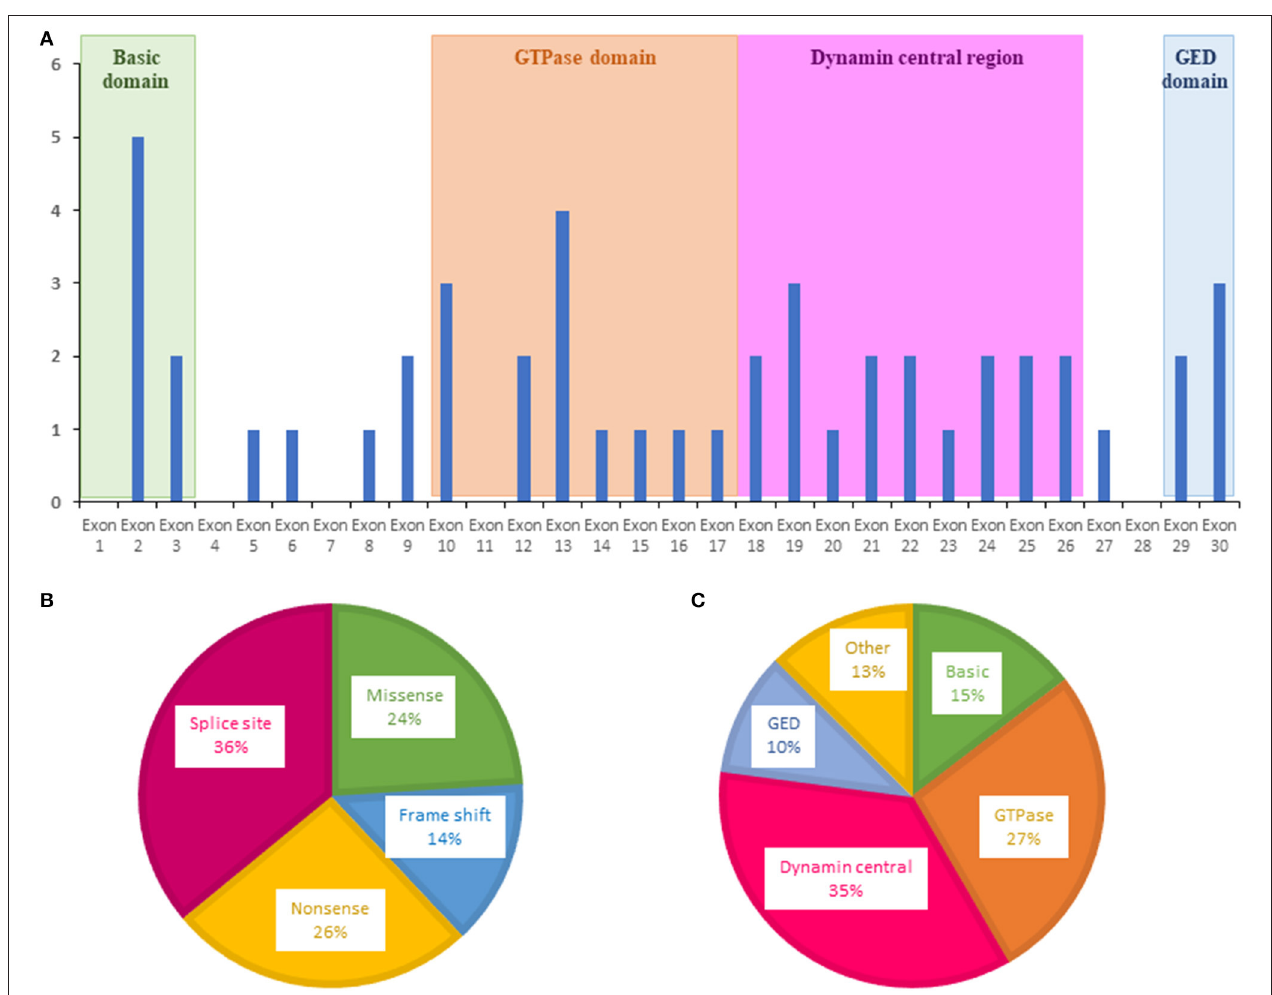
FIGURE 2 | Distribution of variants identified in OPA1 by the ION chip. (A) Exons in which were located the variants are shown as blue bars. (B) Types of variants. (C) Affected domain of the protein. GED, GTPase effector domain.